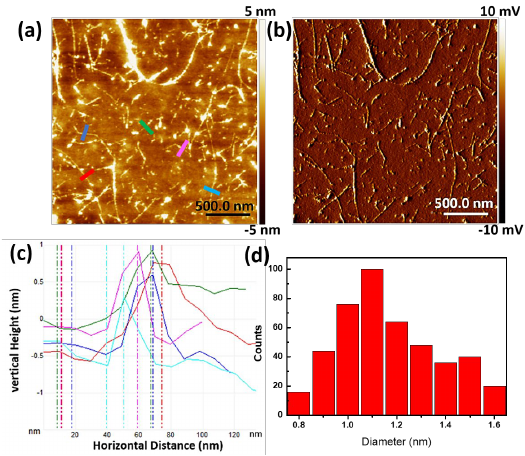
Figure 2. Atomic force microscopy ( a ) height image and ( b ) amplitude error image of dispersed SWNTs on a Si substrate. ( c ) Height analysis of the SWNTs marked by the colored line in image ( a ). ( d ) Diameter distribution of dispersed SWNTs.